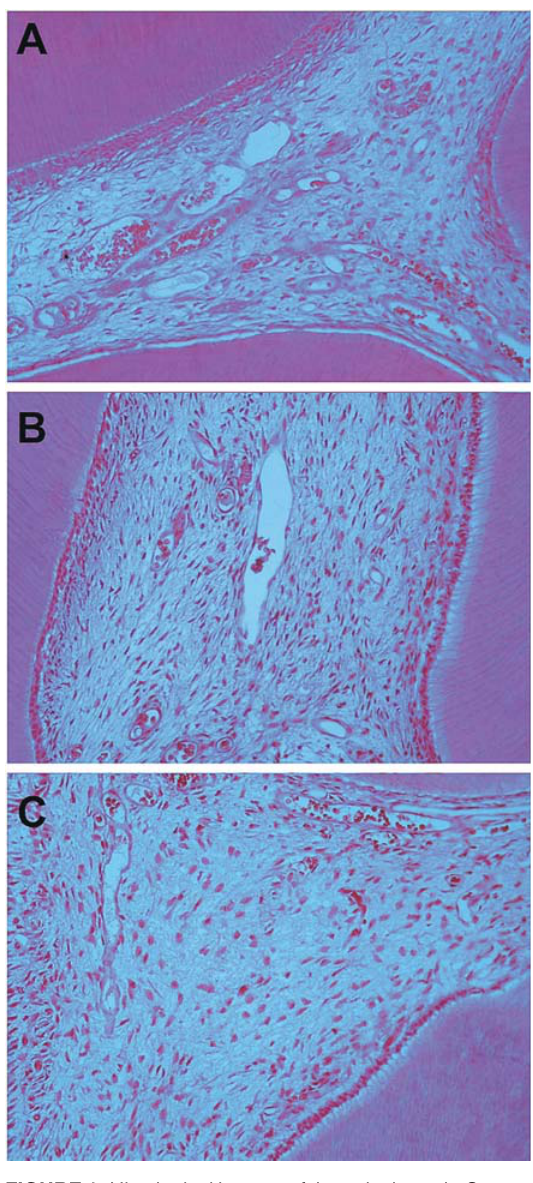
FIGURE 1- Histological images of the pulp tissue in Groups I, II and III. (A) Histological section from a specimen